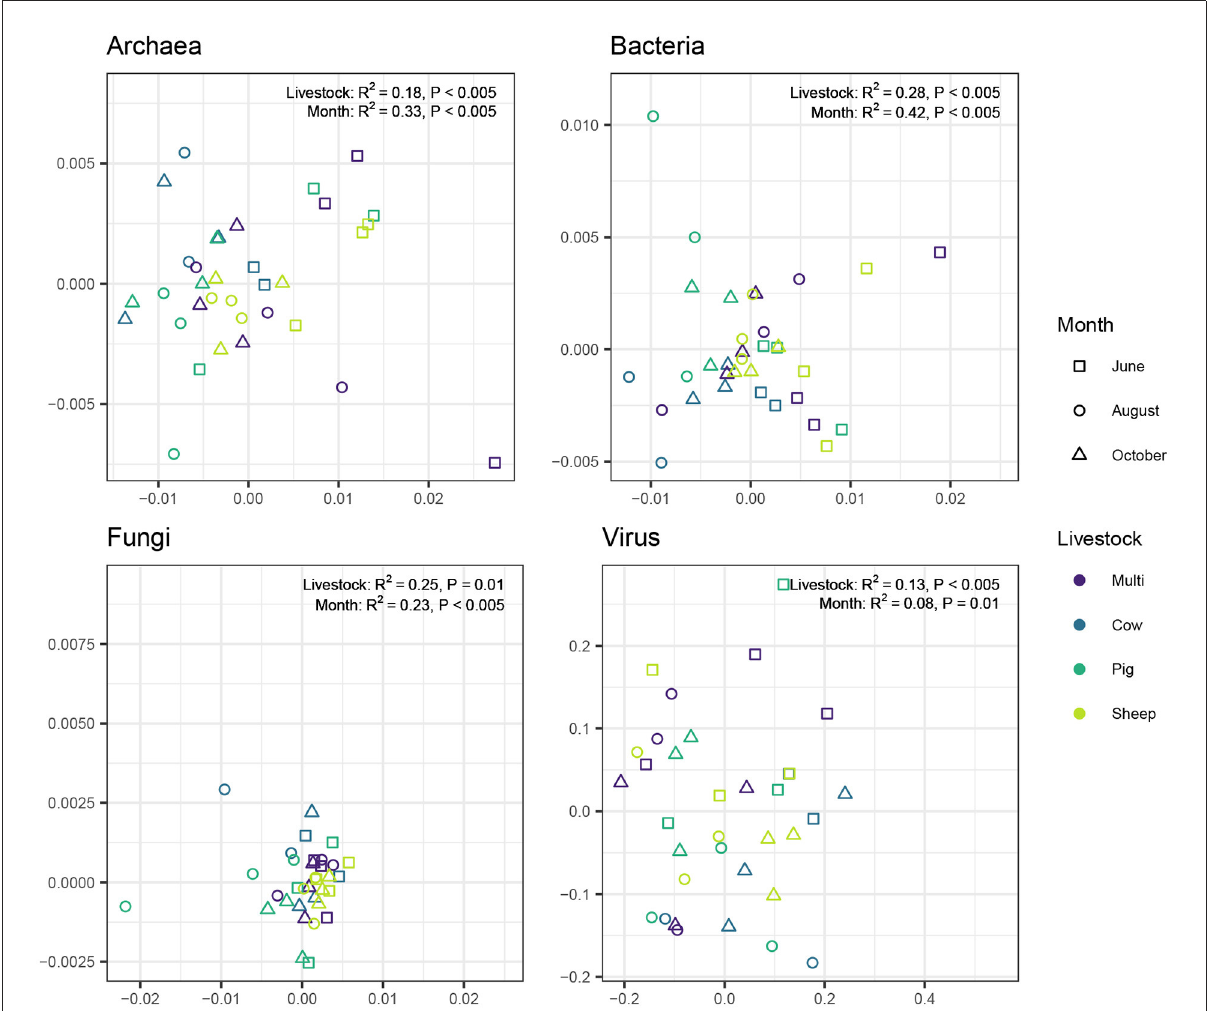
FIGURE6 Principal coordinate analysis visualizing compositional similarity of archaeal, bacterial, fungal, and viral communities, based on Morisita-Horn distances. Point color indicates livestock grazing treatment and shape indicates sampling month. PERMANOVA test results are shown near the top left corner of each